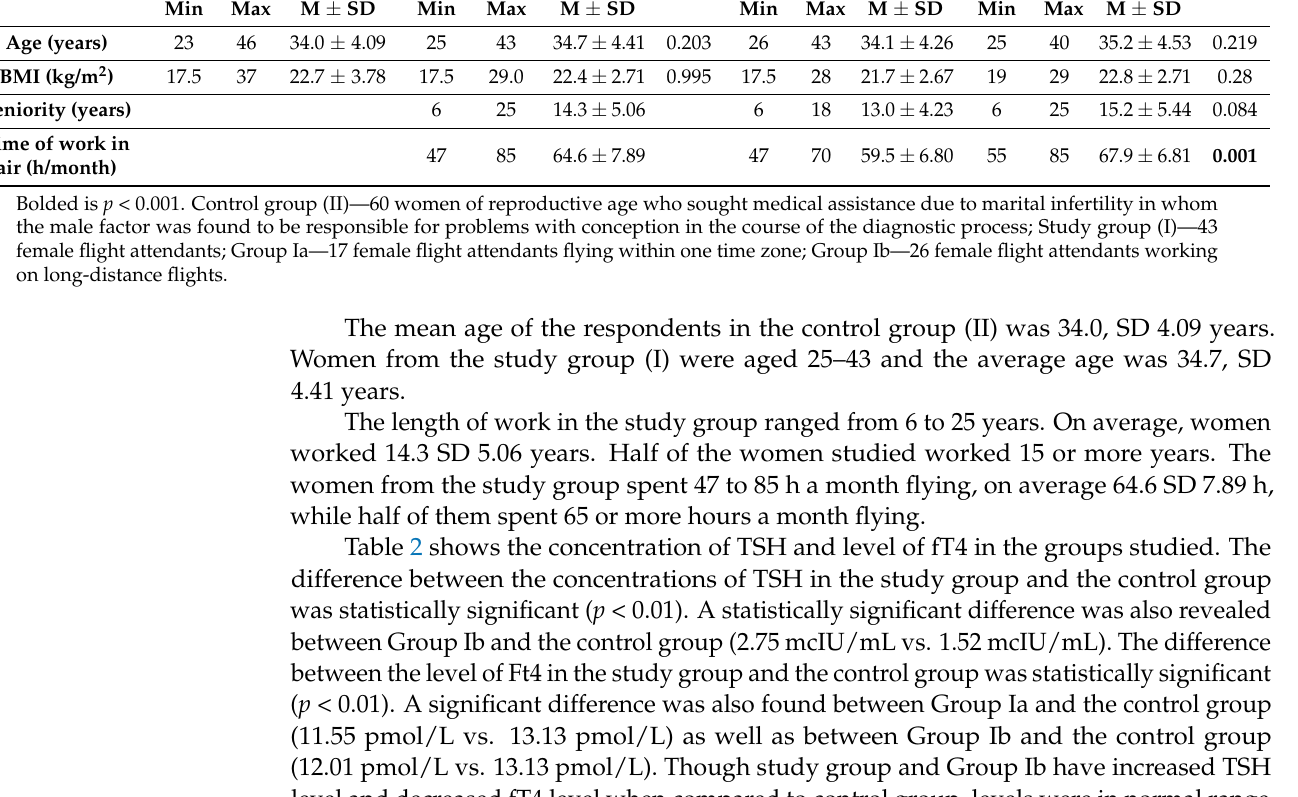
Table 1. The characteristics of the study group and control group, including the subgroups of women flying within one time zone and women serving long-distance flights. Time of work in air was significantly different between groups Ia and Ib. Control Group (II) Study Group (I) ( N = 60) ( N = Variable